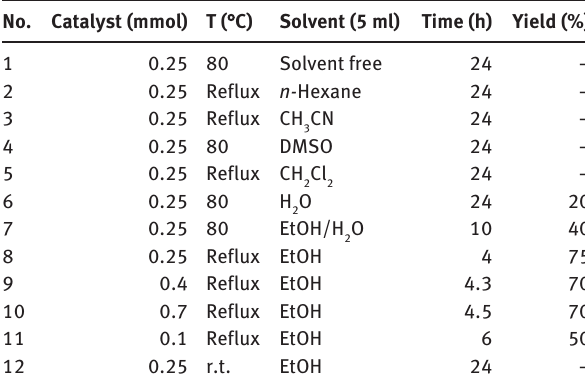
Table 1: Optimization of the reaction